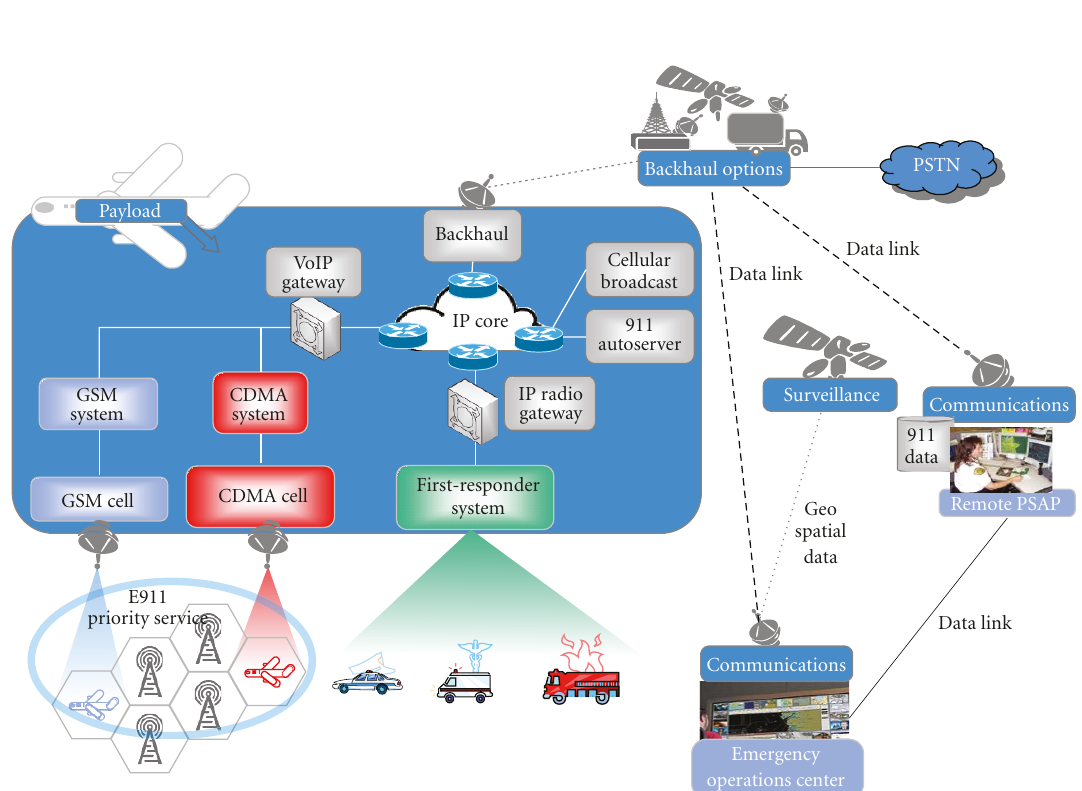
Figure 2: Potential emergency HAP